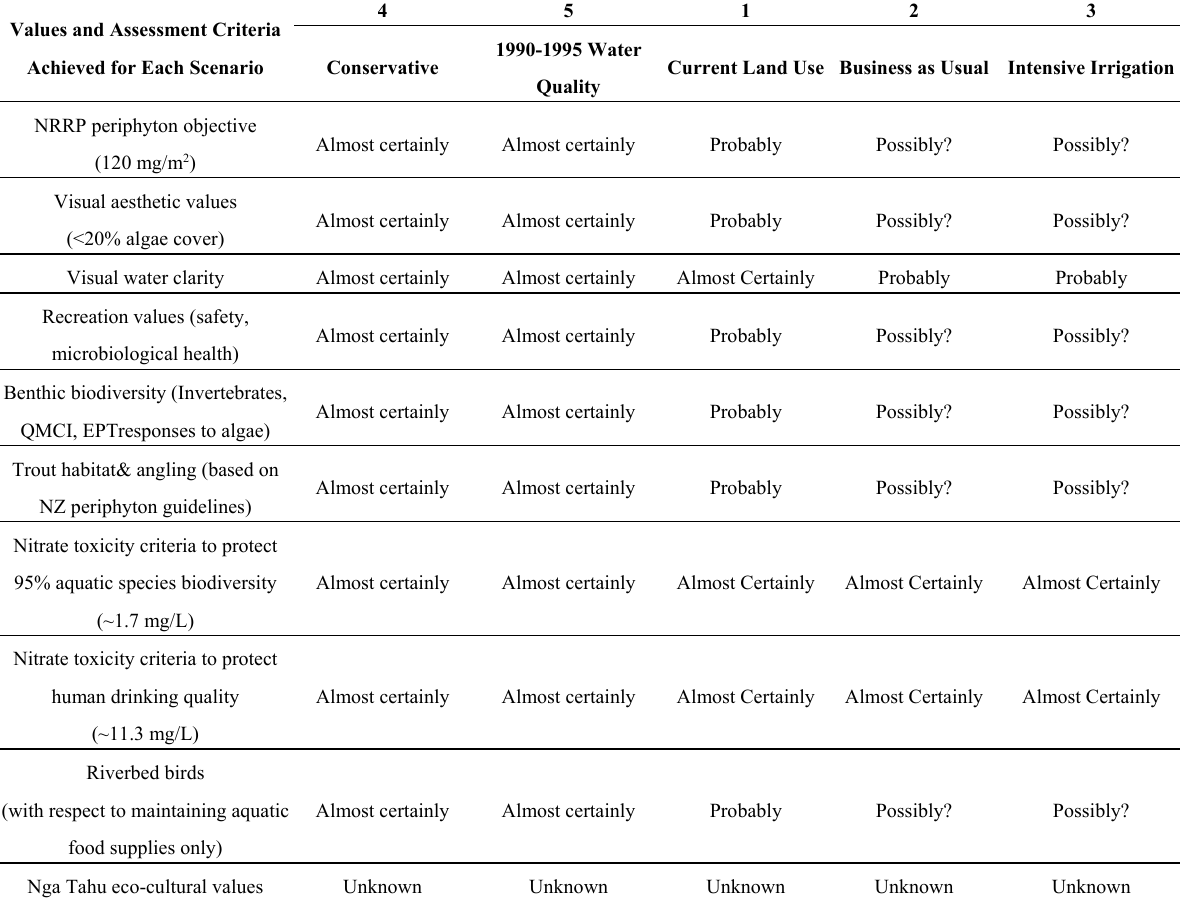
Table A1. Values and assessment by scenario (Hurunui River at Highway